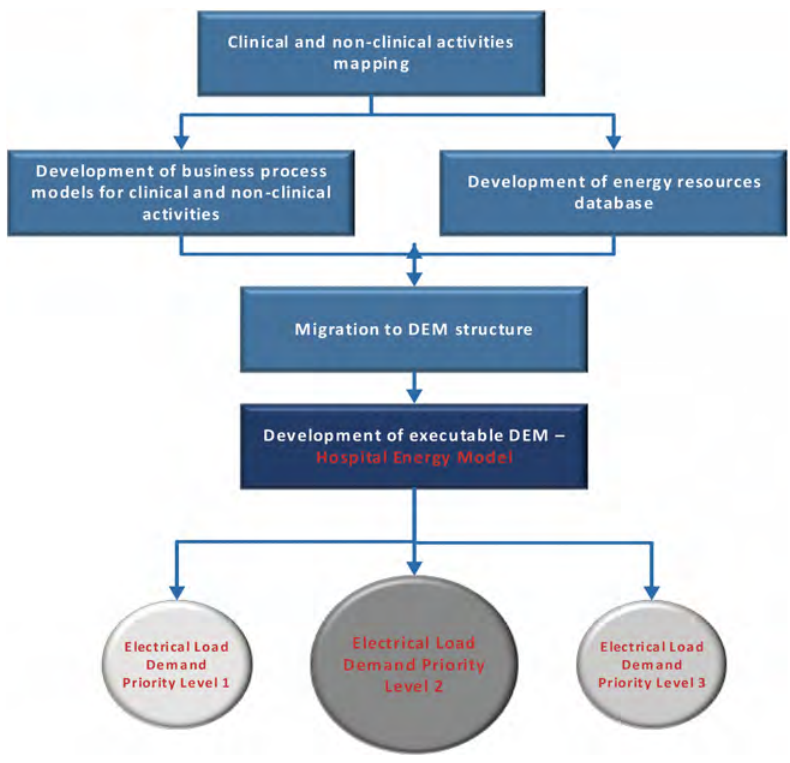
Figure 1. Hospital energy model development